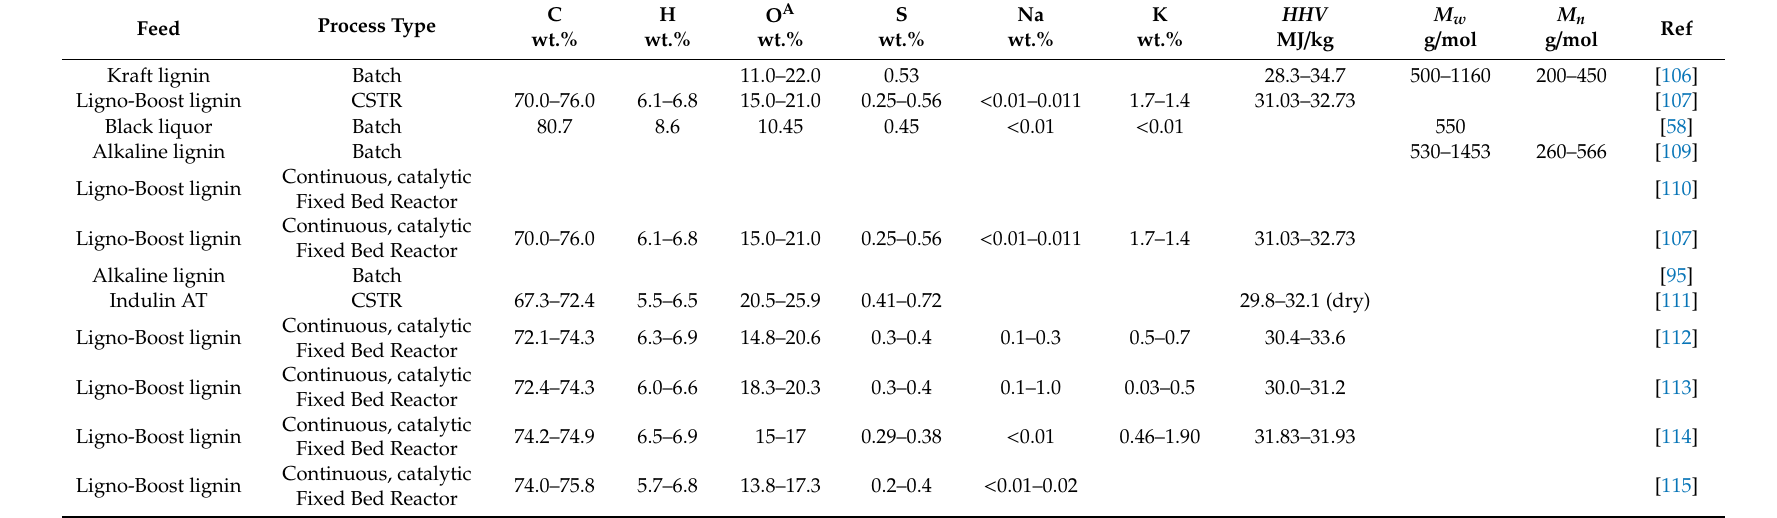
Table 11. The quality of produced